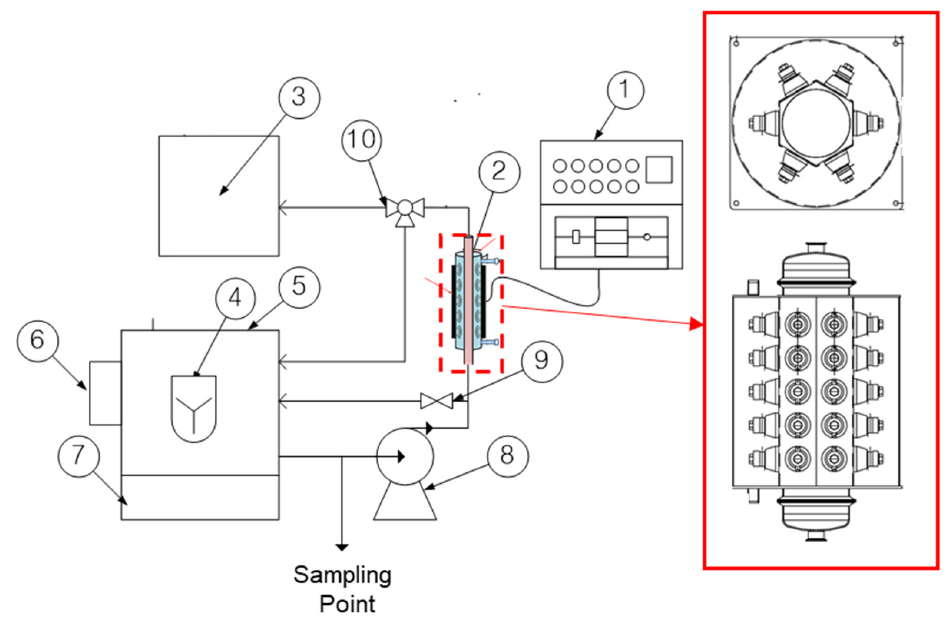
Figure 1. Schematic of flowcell-type ultrasound equipment; ① power supply and ultrasonic generator, ② transducer assembly, ③ oil drain tank, ④ agitator, ⑤ oil supply tank, ⑥ heating oil tank, ⑦ heater, ⑧ oil circulation pump, ⑨ by-pass valve, and ⑩ 3-way valve.